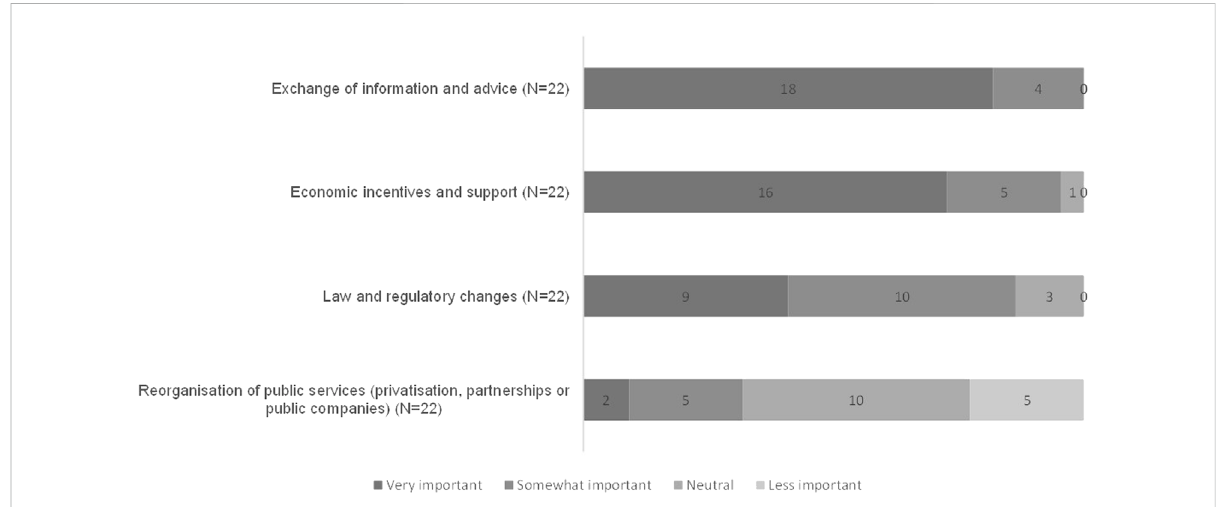
FIGURE 5 Answers to the question “ Given that the businesses is experiencing challenges with COVID-19, how important do you think the following of public administration instruments are to handle the situation? “ . Source: